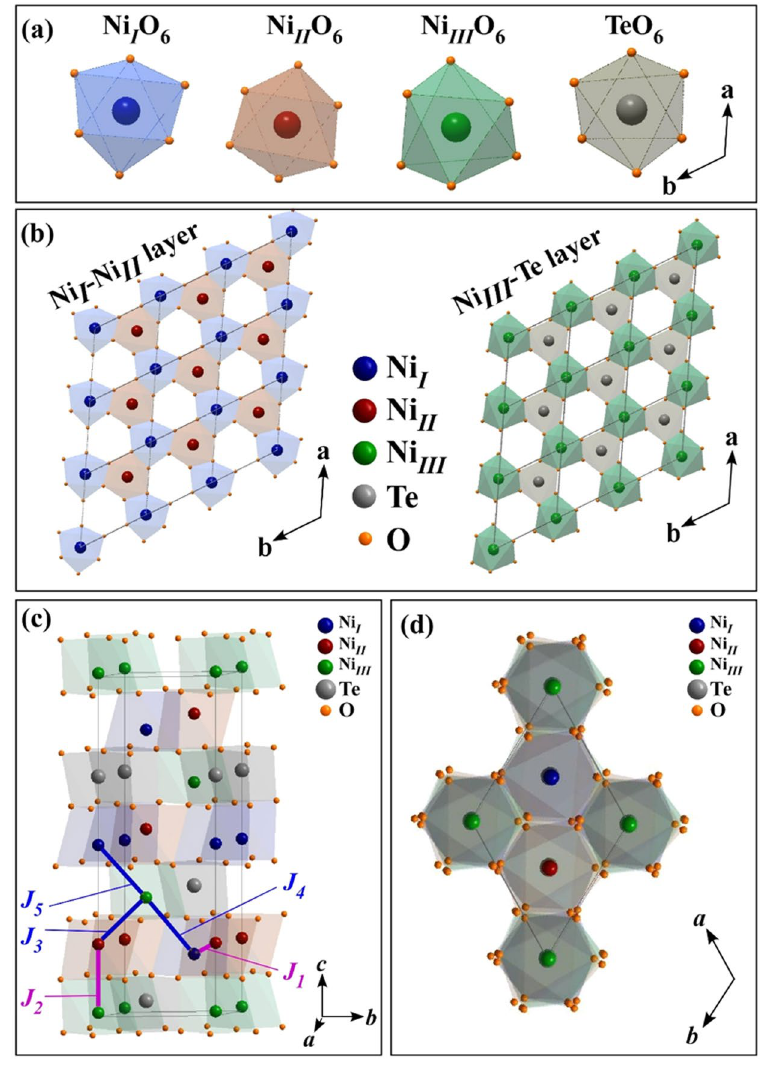
Figure 1. ( a ) Two-dimensional projection of Ni I O 6 , Ni II O 6 , Ni III O 6 and TeO 6 octahedra onto the ab -plane. ( b ) Ni I O 6 -Ni II O 6 and Ni III O 6 -TeO 6 honeycomb-ring layers in the ab -plane, stacked to form an NTO crystal structure with R 3 lattice symmetry. ( c ) NTO crystal structure with magnetic exchange constants ( J 1 -J 5 ) among the Ni ions along various paths in the Ni I -Ni II and Ni III -Te planes. ( d ) A different view of the NTO crystal structure in the ab